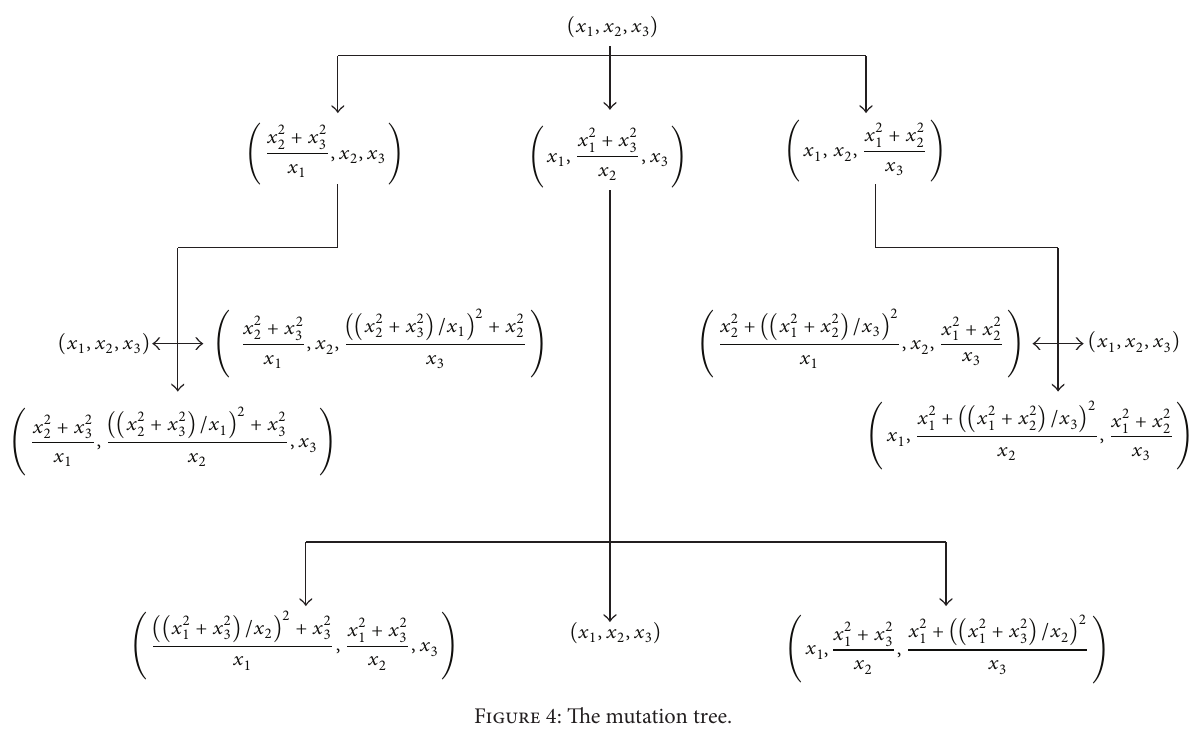
Figure 4: The mutation